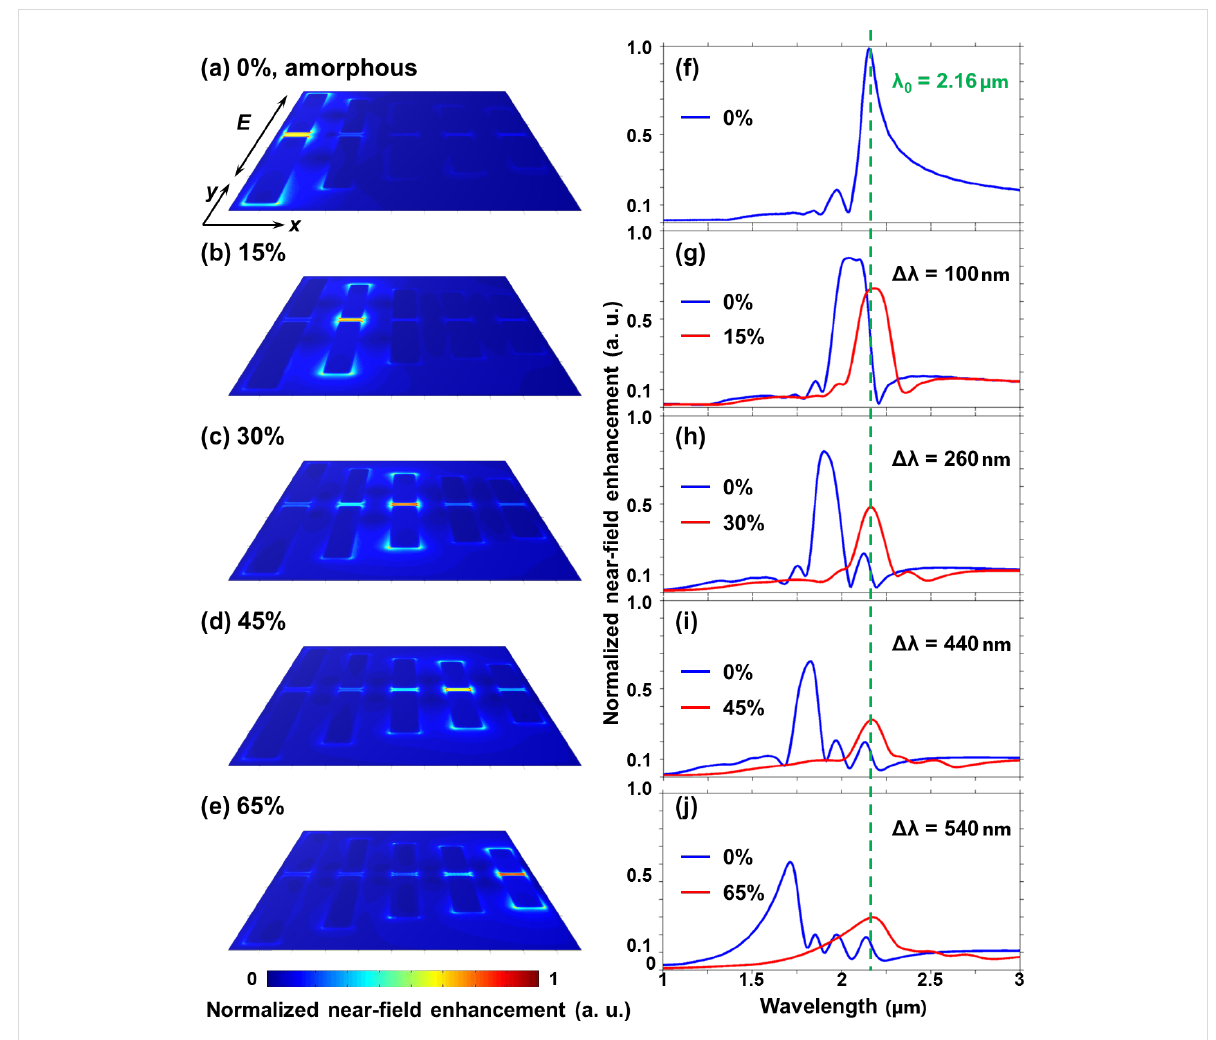
Figure 3: Controlling the near-field excitation of nano-antennas with a quantitative modulation on the phase transition of an underneath GST thin layer. When the crystalline proportion of the phase-change thin film is changed from the amorphous state (0%) to a portion of 65% crystallization, the nano-antennas can be selectively excited at different intermediate phases, generating nanoscale light localizations positioned on the landscape of constituent dipole nano-antennas. A plane wave is normally incident onto the array at an excitation wavelength of 2.16 µm and the polarization direc- tion is parallel to the antennas in the y direction. The centre-to-centre distance between neighbouring antennas is 100 nm, giving a step resolution of λ /20 in this plasmonic